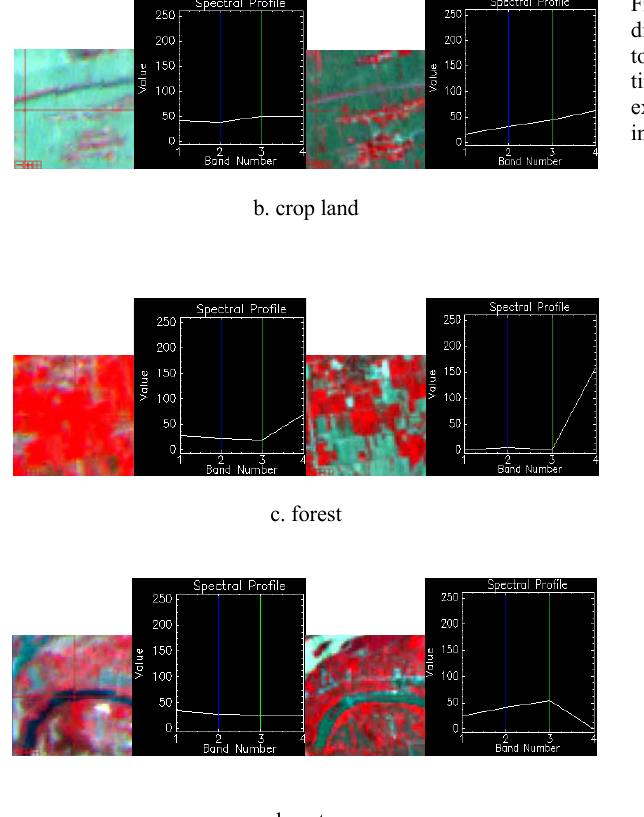
Fig.3 Flow of change detection of man-made area with HJ image and TM